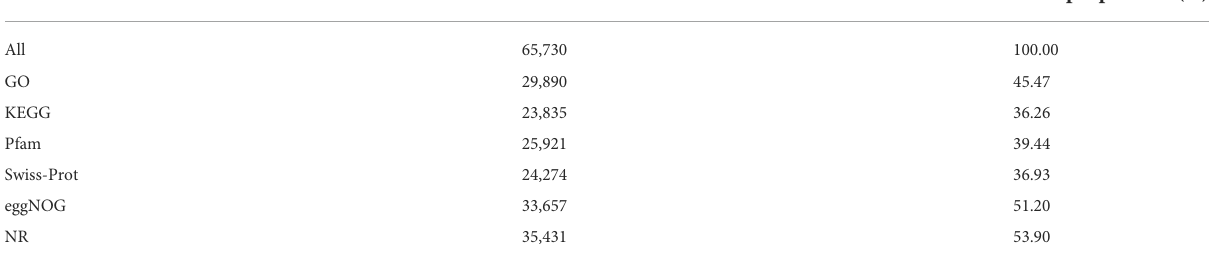
TABLE 2 Functional annotation